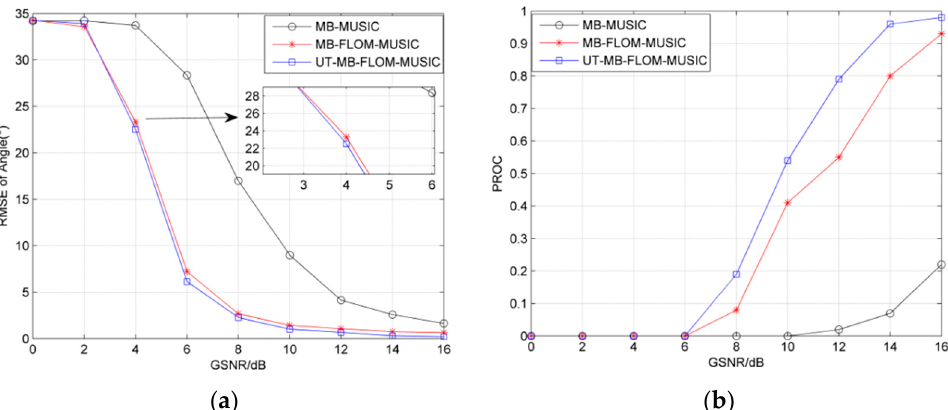
Figure 6. RMSE and probability of convergence (PROC) of the angle under different GSNR, α = 1.3